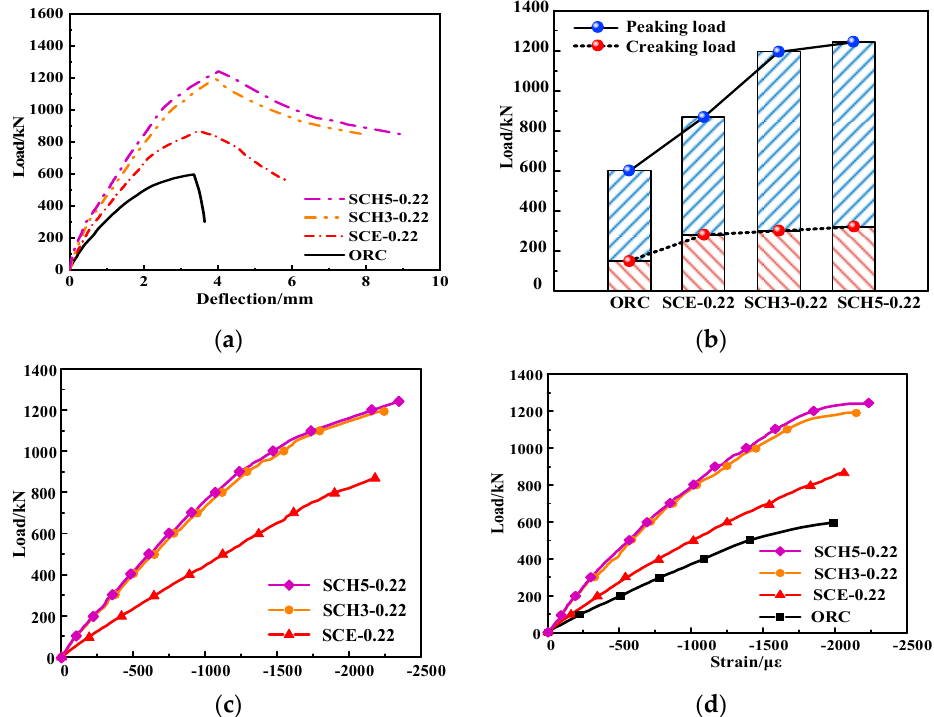
Figure 14. Comparison of specimens with different reinforcement methods. ( a ) Load-midspan lateral deflection curve; ( b ) Cracking and peaking load variation curves; ( c ) Load-ECC compressive strain curve; ( d ) Load-longitudinal bar compressive strain curve.